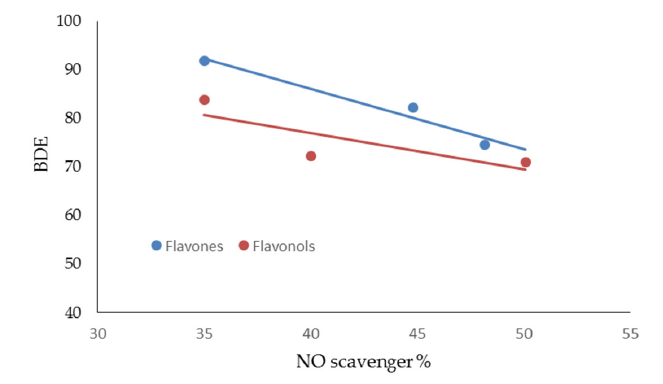
Figure 6. Relationships between the NO scavenger % and binding dissociation enthalpy (BDE) values for flavones and flavonols.